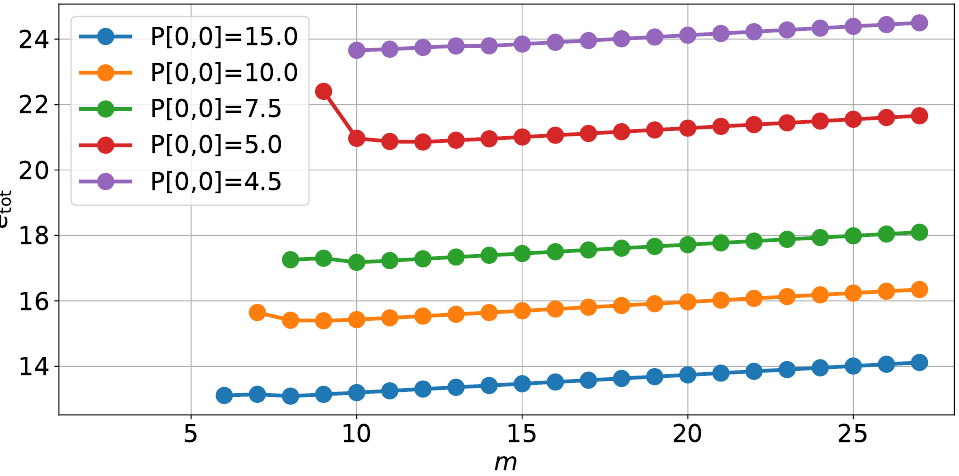
Figure 6. The energy needed to store each variable in an unreliable memory to achieve various desired variances of estimation error on the position depending on the number m of bits in the representation with the optimal energy